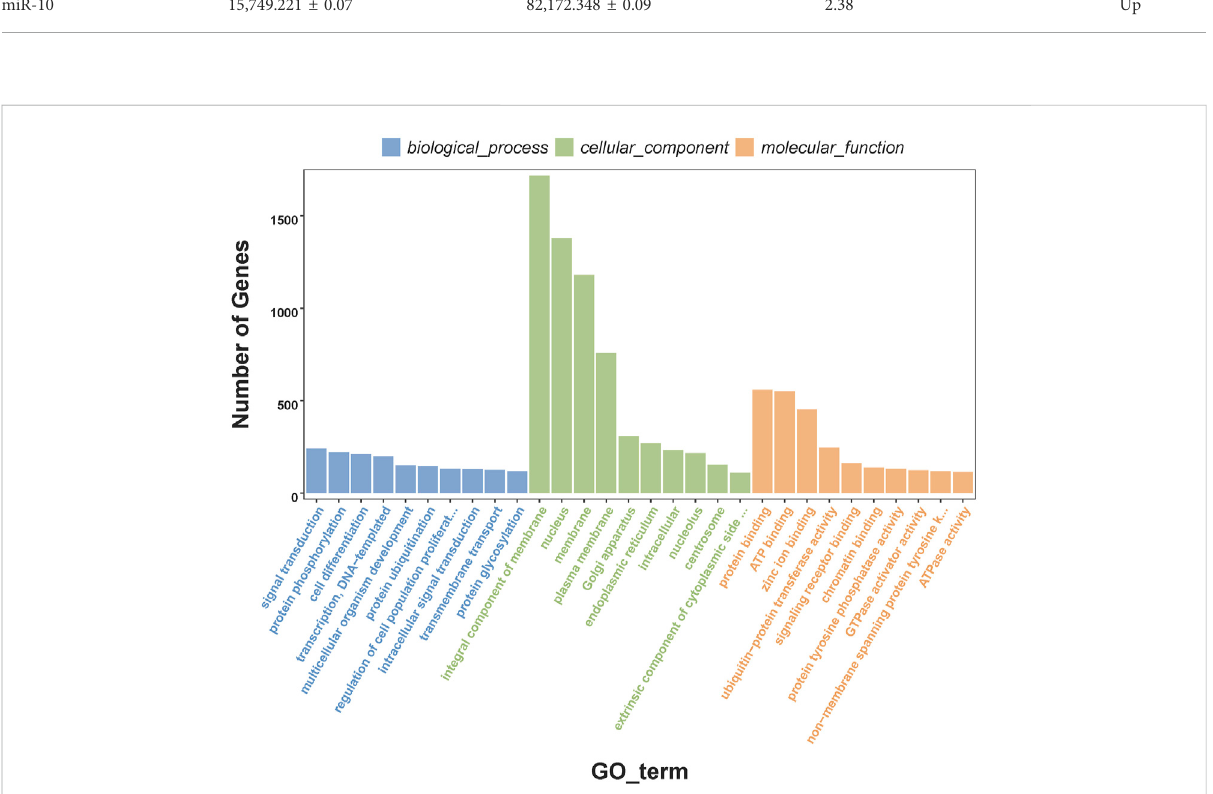
FIGURE 2 Top 10 enriched GO terms of the target genes of differentially expressed